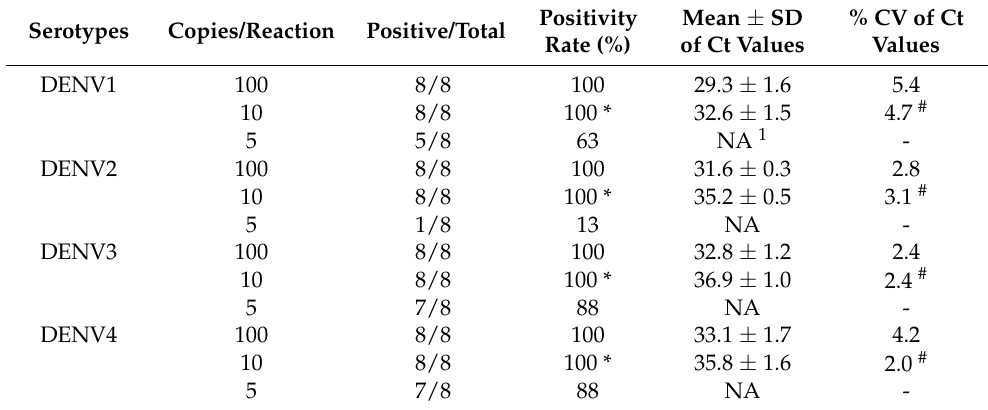
* Limit of detection (LoD). # Limit of quantification (LoQ). 1 NA represents not analyzed. Levels of DENV genome measured by both assays provided high correlation (R > 0.9 and p < 0.0001) when DENV RNA (Figure 2a) or cultured DENV (Figure 2b) was used as the RNA template, but the correlation decreased (R = 0.5483 and p < 0.0001) when measured in patients’ plasma (Figure 2c). Interestingly, in both cultured virus and patient plasma (Figure 2b,c), the levels of the DENV genome measured by 3 (cid:48) -UTR RT-PCR were less than the DENV genome measured by targeting the coding sequences and, noticeably, some were detected by only coding sequences (X-axis) or 3 (cid:48) -UTR (Y-axis).